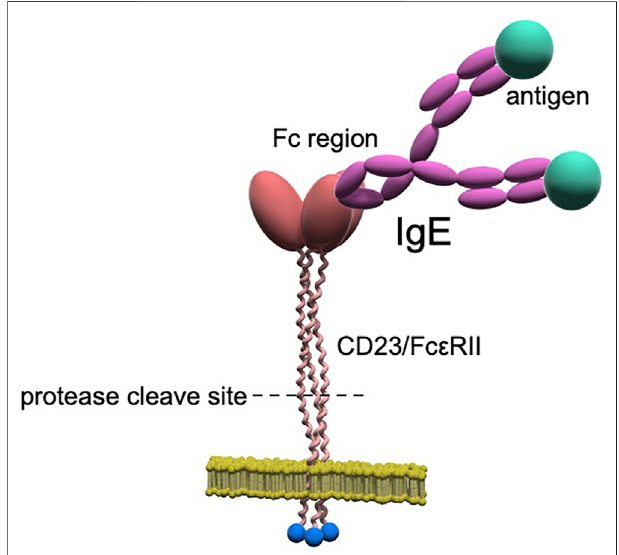
FIGURE 2 | CD23/Fc ε RII structure. CD23 is a type II membrane protein withanintracellular N-terminusandextracellularC-terminusandformsnormal trimers. Thestalkportionconsistsofaproteolytic regioncleaved byproteases (e.g., ADAMs), and the cleaved extracellular region forms soluble CD23/ Fc ε